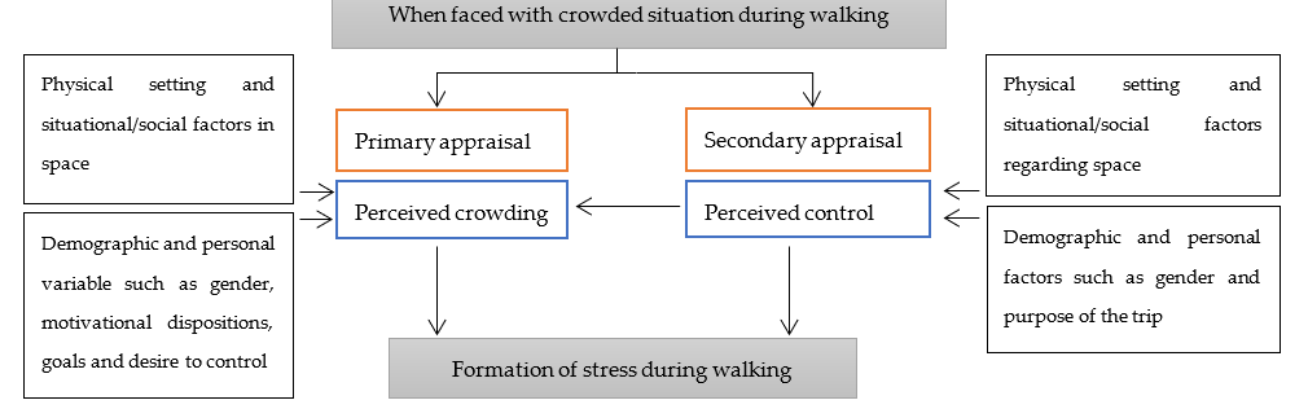
Figure 2. The process of stress formation when faced with crowded spaces during walking.